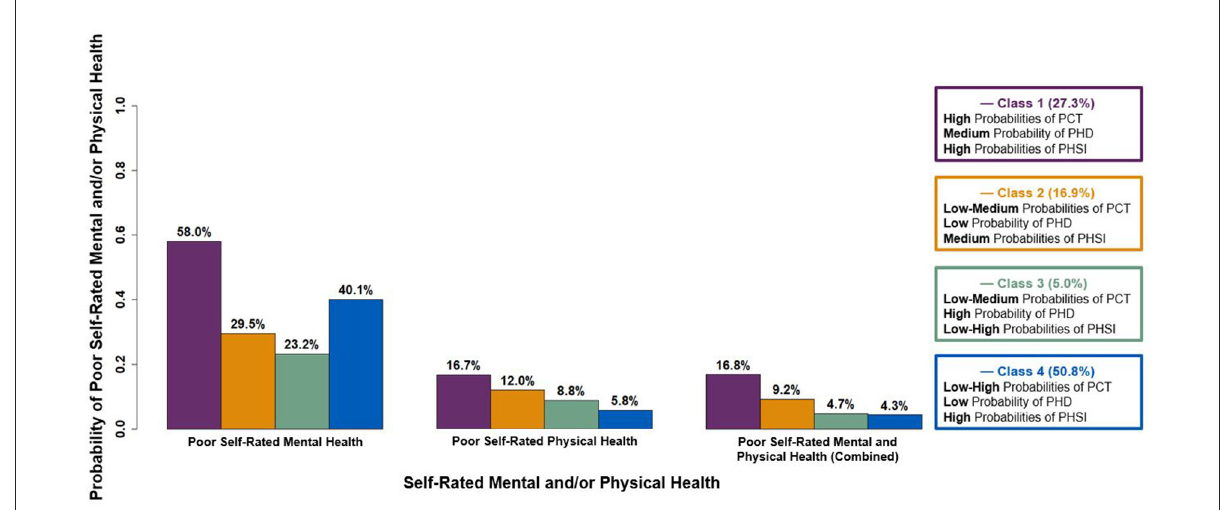
FIGURE2 Probabilities of poor self-rated mental and/or physical health for each latent